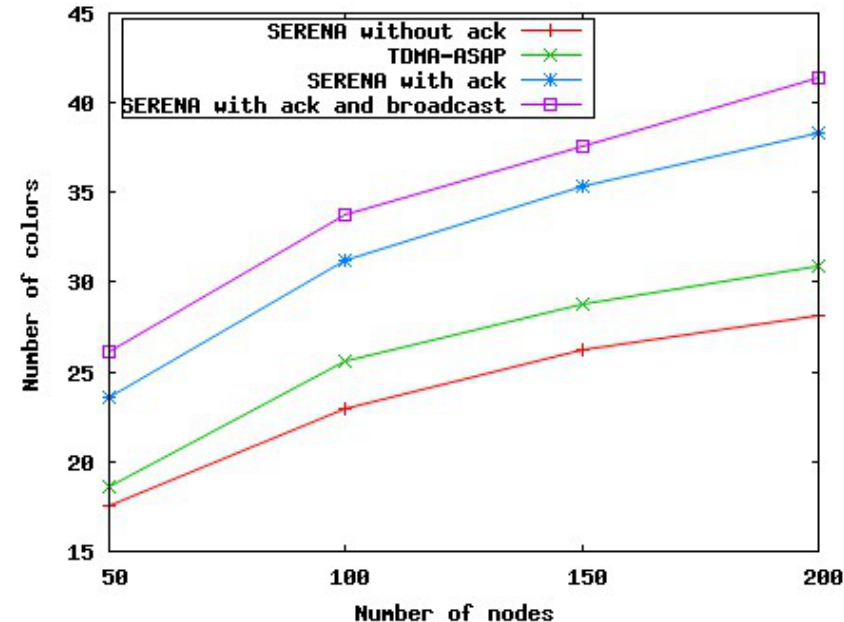
Figure 13. Comparison of the number of colors used in SERENA and